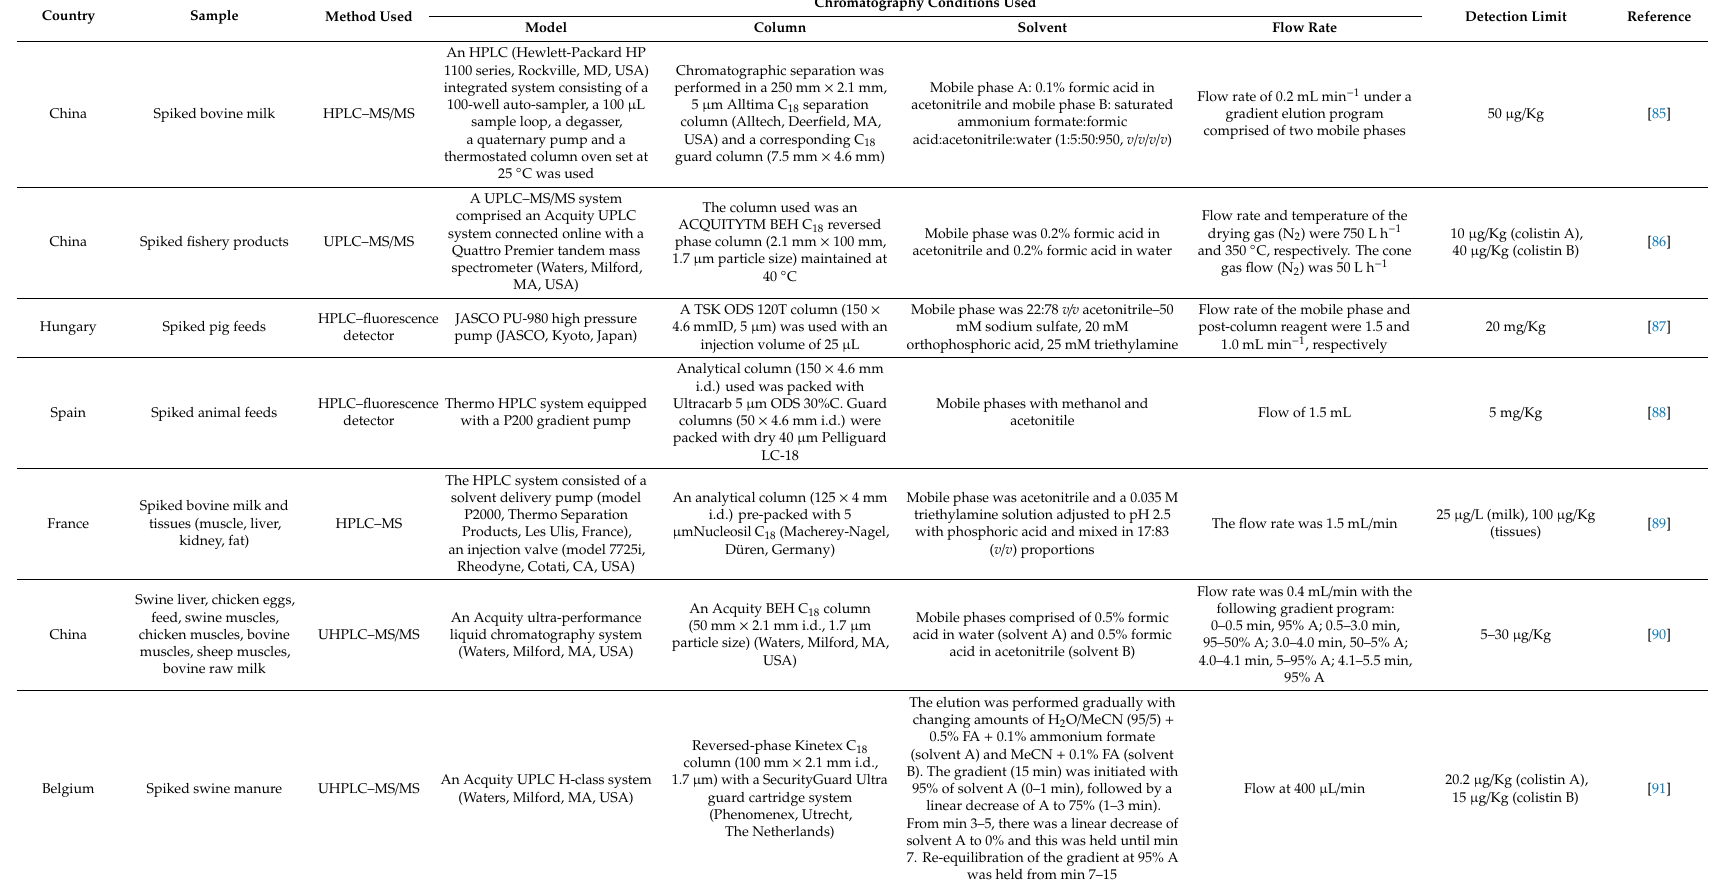
Table 3. Di ff erent conventional methods used for the detection of colistin in animal-based